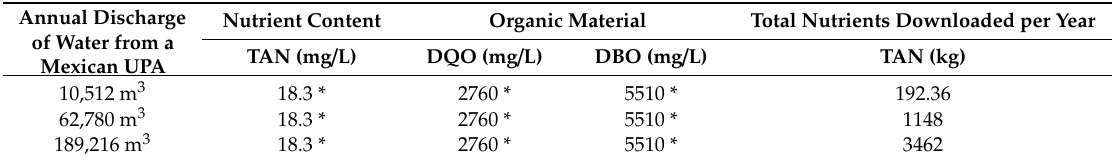
Table 4. Main results of Mexican aquaculture production units (APUs). Estimation of nutrient discharges, according to discharge diameter and replacement